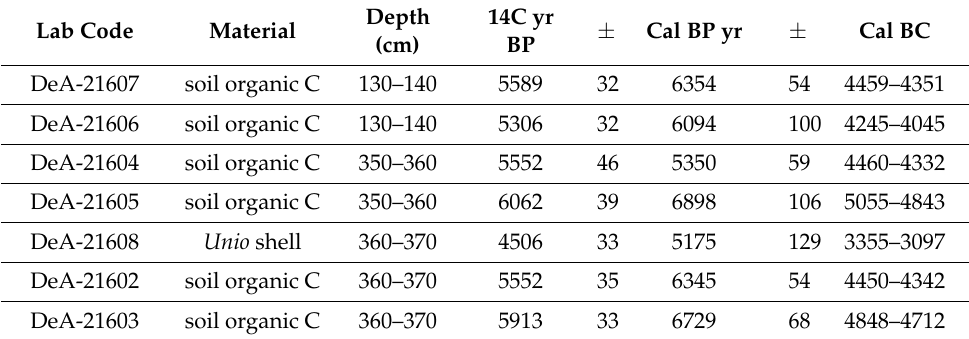
Table 4. Results of the radiocarbon measurements on the Cs á sz á rn é